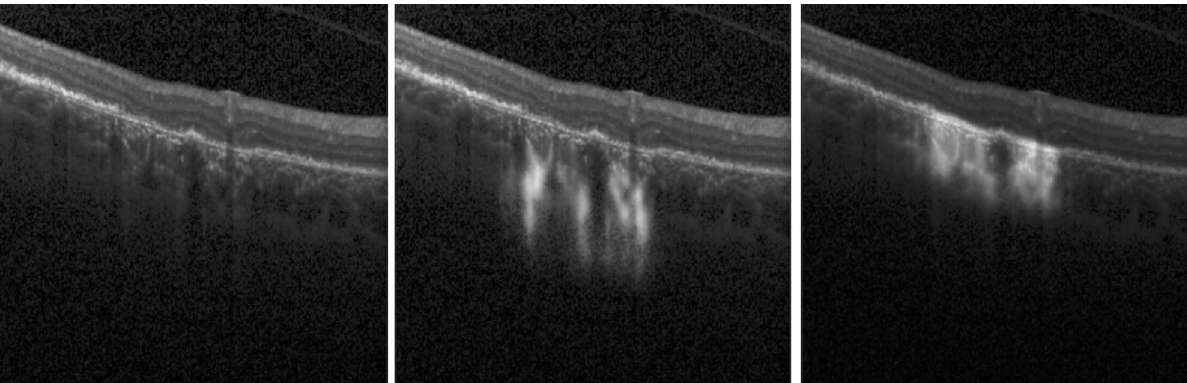
Figure 7. Comparison of outputs obtained with models trained without and with layer information. Left: input b-scan, middle: output of CNN trained without layer prior, right: output of CNN trained with layer prior overlaid on input b-scan. The network trained using only maximum probability projection focuses mostly on increased hypertransmission in atrophic regions, while the other model also looks at RPE